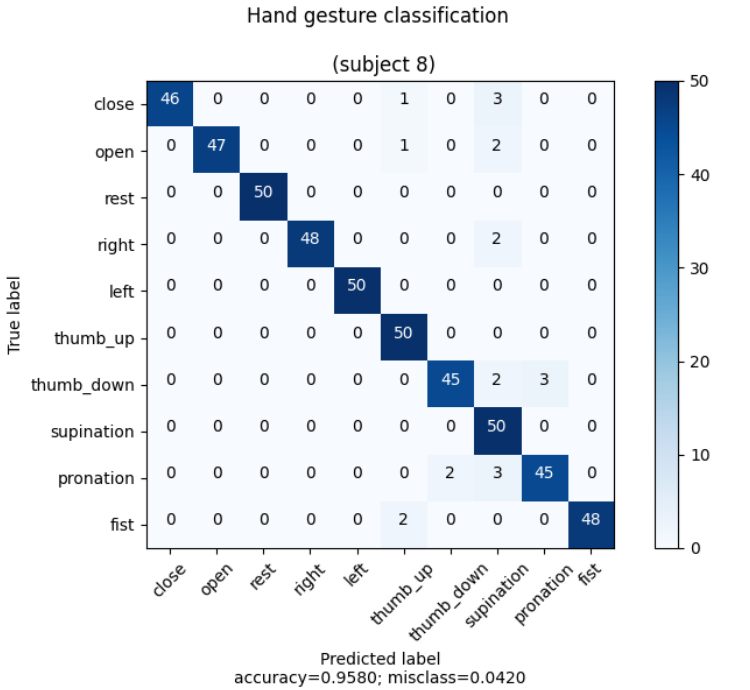
Figure A8. Confusion matrix of a subject who did not participate in data collection (subject